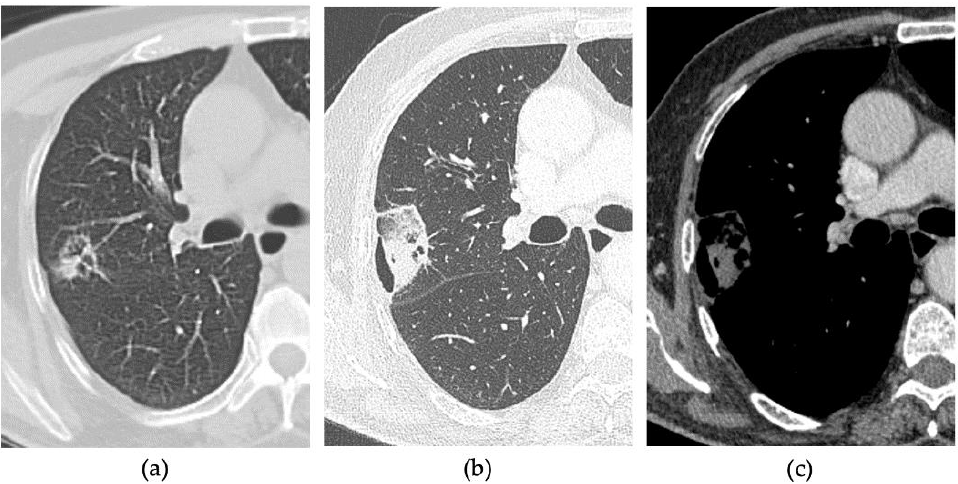
Figure 4. 80-years-old man with lung metastasis from larynx carcinoma in the right upper lobe. ( a ) Axial pre-treatment CT. Axial 1-month follow-up CECT after MWA with VPS shows ( b ) a large consolidation with well-defined margins and cavitation and ( c ) with contrast enhancement.